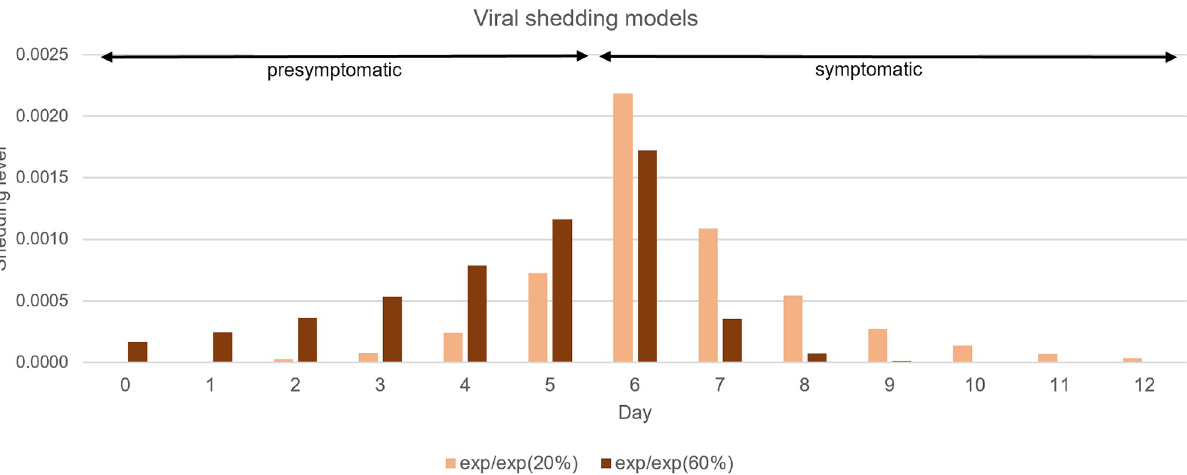
Fig 2. Viral shedding models. The bar charts show the shedding level of an infected individual whose presymptomatic period and symptomatic period are 6 and 7 days, respectively. The percentage in the parenthesis of each model corresponds to the percentage of shedding during the presymptomatic state ( P ) relative to the total shedding volume. The peak shedding level differs in the two models, but the total shedding volume remains the same.